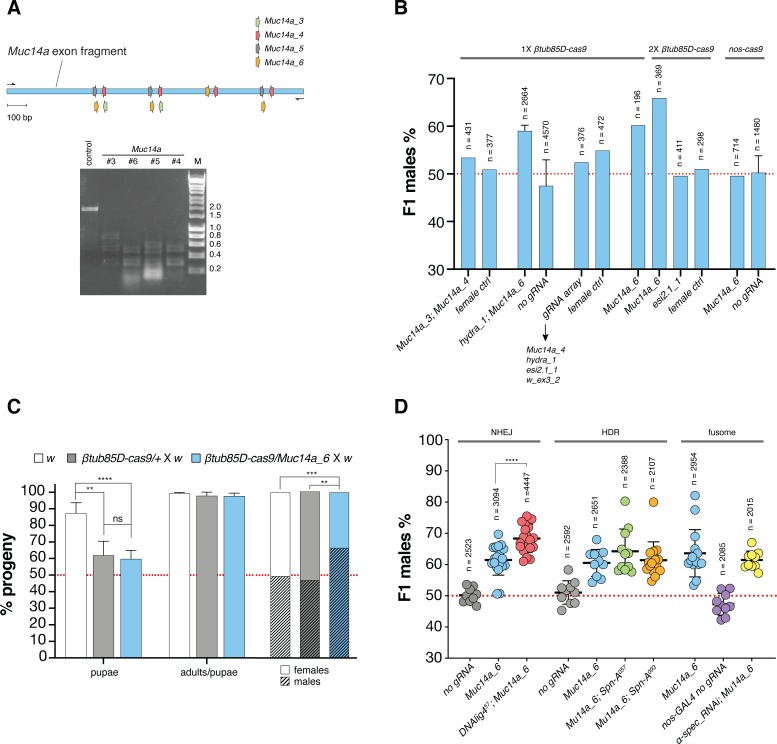
(A) Assay to detect CRISPR/Cas9-mediated cleavage in vitro. The region of the Muc14a gene that was amplified contains at least 2 binding sites for each of the gRNAs: Muc14a_3, Muc14a_4, Muc14a_5 and Muc14a_6 (top). The PCR amplified DNA fragment was used as a digestion target for Cas9/gRNA cleavage reactions in vitro (bottom). Reactions were run on a gel to detect cleavage. A control without gRNA was included. (B) Analysis of combinations of gRNAs and Cas9 sources for X-shredding. Average male frequencies in the F1 progeny are shown for each parental genotype with a single copy of βtub85D-cas9 transgene (1X), two copies of βtub85D-cas9 transgene (2X) or one copy of nos-cas9 (grey bars). All lines were crossed to wild type w individuals. The reciprocal cross (female ctrl) or heterozygote βtub85D-cas9/+ or nos-cas9/+ without gRNA (no gRNA) were used as control. The black arrow indicates gRNAs in the multiplex array and the red dotted line indicates an unbiased sex-ratio. Crosses were set as pools of males and females or as multiple male single crosses in which case error bars indicate the mean ± SD for a minimum of ten independent single crosses. For all crosses n indicates the total number of individuals (males + females) in the F1 progeny counted. (C) Developmental survival analysis of the F1 progeny of Muc14a_6/βtub85D-cas9 males crossed to w females compared to w and βtub85D-cas9/+ control males crossed to w females. Left columns: embryos to pupae survival rate; central columns: pupae to adults survival rate and right columns: fraction of males and females in adults. Bars indicate means ± SD for at least ten independent single crosses. Statistical significance was calculated with a t test assuming unequal variance. **p < 0.01, ***p< 0.001 and ****p< 0.0001. (D) Influence of DNA repair and fusome integrity on X-shredding. Male frequencies in the progeny of DNAlig457 (red), spn-A057 (green) and spn-A093 (orange) mutants and UAS_α-spectrinRNAi; nos-GAL4 (yellow) knockdown mutants. The F1 sex-ratio of the progeny of males carrying Muc14a_6/βtub85D-cas9 in the mutant backgrounds was compared with those of βtub85D-cas9/+ (grey), Muc14a_6/ βtub85D-cas9 (cyan) and nos-GAL4/+ (purple) control males. Each dot represents the percentage of F1 males from a cross between one male and three females. n is the number of individuals (males + females) in the F1 progeny. Bars show means ± SD for at least ten independent single crosses. Statistical significance was calculated with a t test assuming unequal variance. ****p< 0.0001. All crossing data in S3 Table.